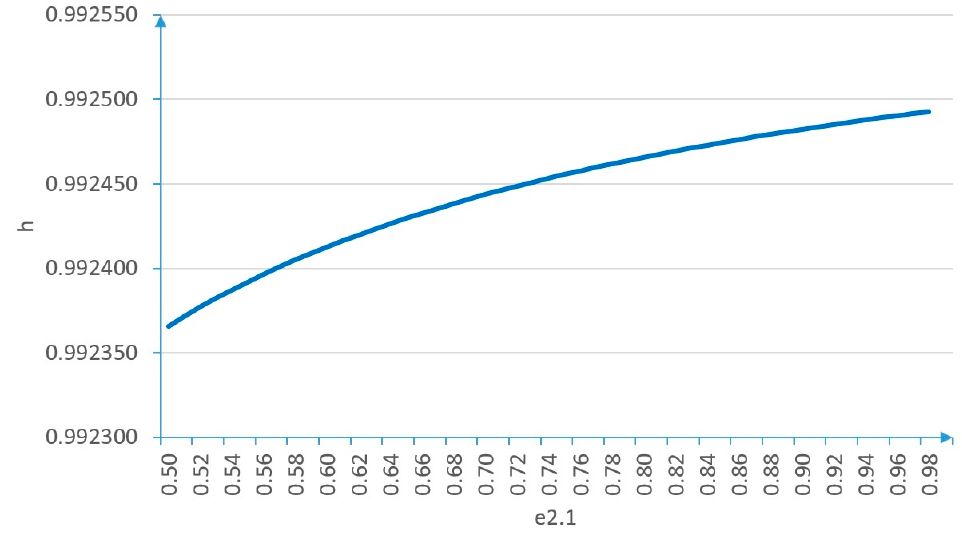
Figure 11. CQoPS simulation result in the e2.1 observation function. The result of the operation of software written by one of the authors of the article.